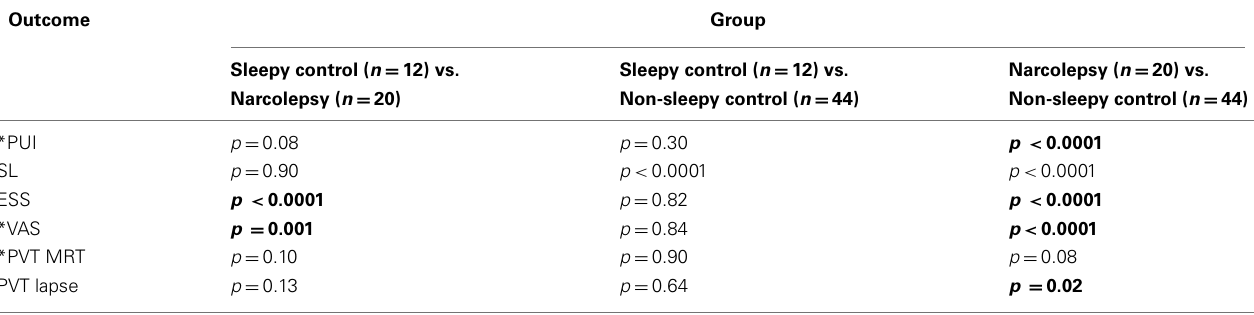
TableA1 | Comparisons of sleepy control sub-group on outcomes. Outcome